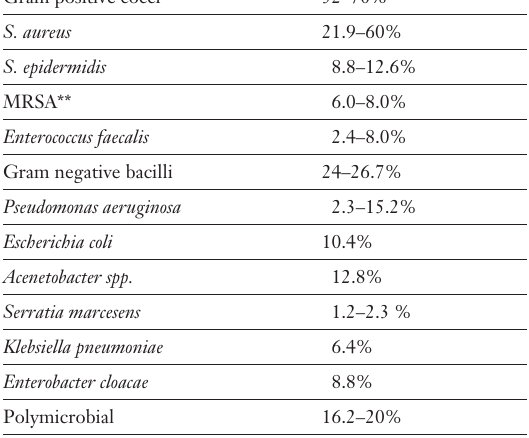
Figure 2 Prevalent bacterial flora associated with vascular access-re- lated bloodstream in- fections in a large haemodialysis centre of Eastern Province